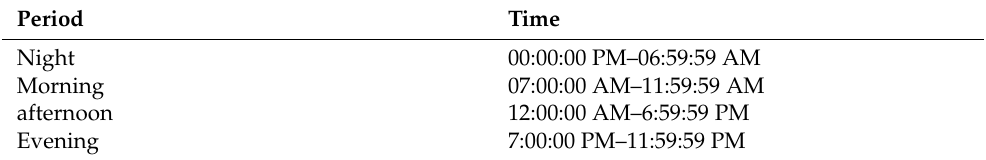
Table 3. Day division in periods.